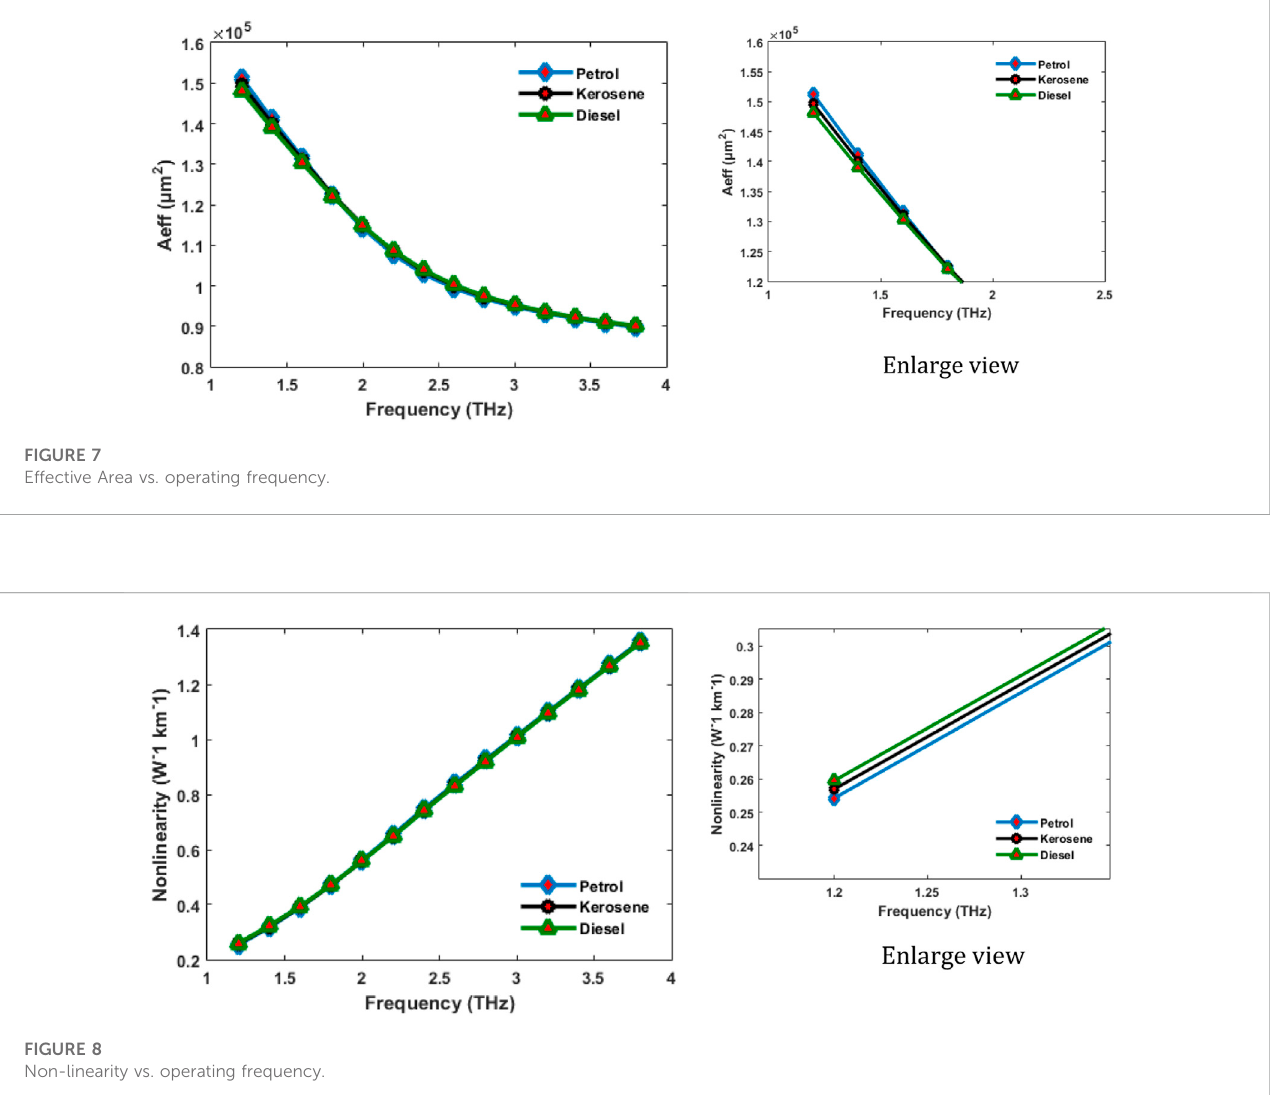
TABLE 1 Comparison with previously reported works. PhCF